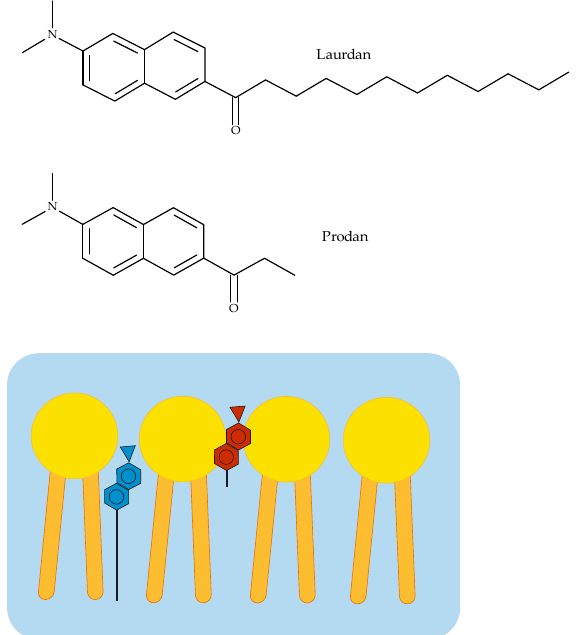
Figure 6. Chemical structure and location of Laurdan and Prodan in the phospholipid bilayer. Prodan molecules (red) locate closer to the hydrophilic surface of a bilayer than Laurdan (blue), in which the fluorophore is positioned closer to the phospholipid glycerol groups [33]. The addition of all studied compounds to EYPC liposomes incubated with fluorescent probes resulted in quenching both Laurdan and Prodan fluorescence. For both fluorescent probes, the Stern–Volmer plots representing fluorescence quenching were linear in the presence of all studied compounds (Figures 7–9).